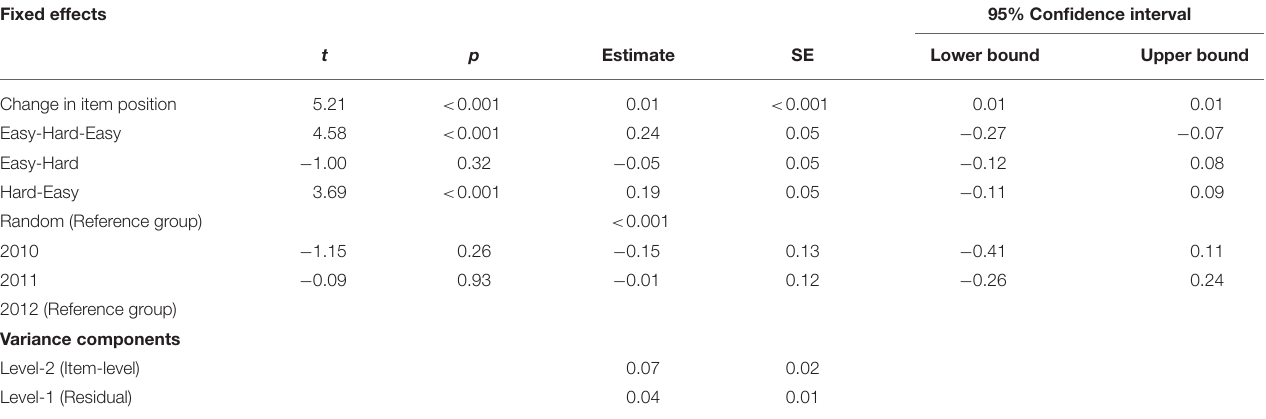
TABLE 5 | Random intercept model: DIF estimate on item position changes and item orders controlling for year of exposure ( N =